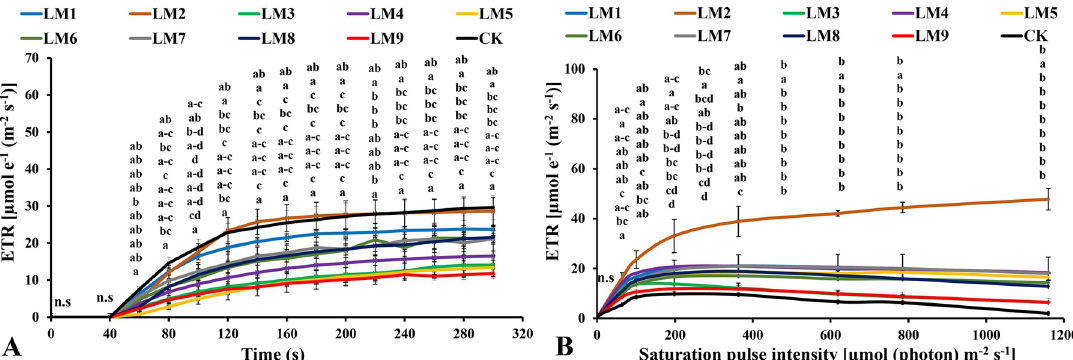
Fig 11. Effects of LED light modes on chlorophyll a fluorescence induction kinetics of the dark-acclimated (A) and RLC of the light- acclimated (B) of electron transport ratio (ETR) in rocket leaves. The points are means ± SE of 4 replicates followed by the same letters meaning no different significantly according to the Duncan test (P � 0.05). Sort significance letters from top to bottom according to the treatments (ML1-CK). LM1 = A1:B1:C1, LM2 = A1:B2:C2, LM3 = A1:B3:C3, LM4 = A2:B1:C2, LM5 = A2:B2:C3, LM6 = A2:B3:C1, LM7 = A3:B1:C3, LM8 = A3:B2:C1, LM9 = A3:B3:C1, CK = White fluorescent